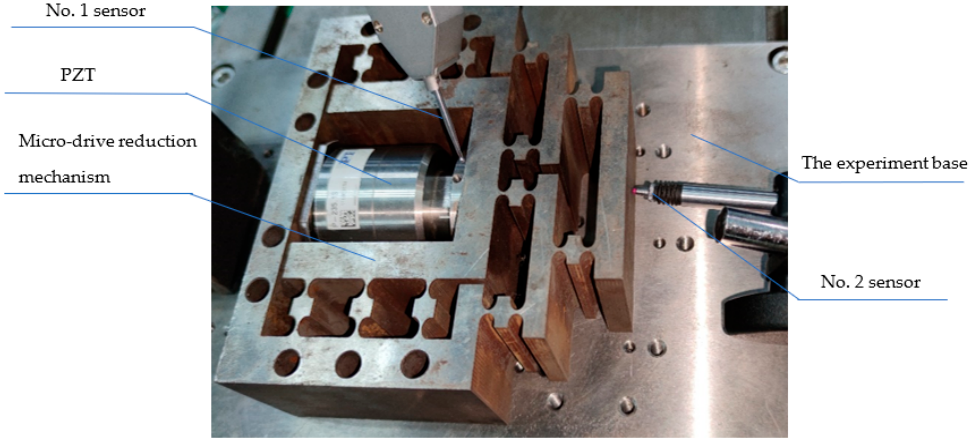
Figure 16. Diagram of the experiment on the micro-drive reduction system.